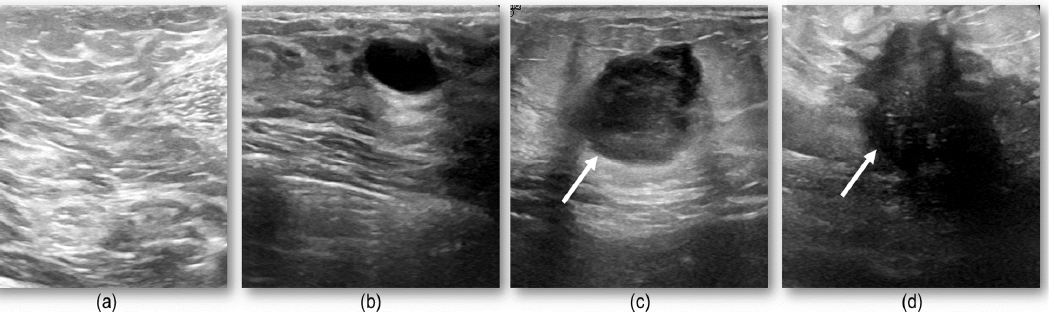
Figure 2. Four examples of ultrasound: ( a ) shows a normal case with no suspicious lesion, ( b ) depicts a benign nodule, while ( c , d ) show malignant tumors. These images show the challenge in discrimi- nating different group of lesions with different textural complexities.